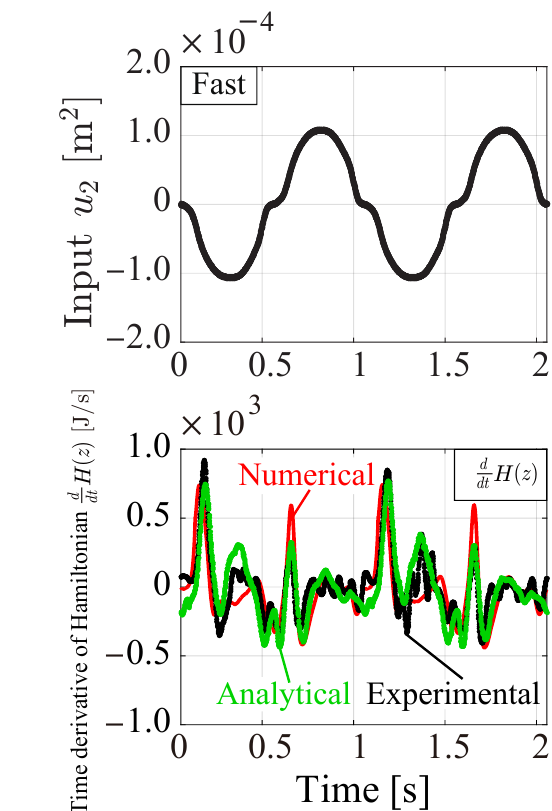
Figure 10. Experimental (black) vs. numerical (red) vs. analytical (green) time responses of the time derivative of the Hamiltonian. (Energy behavior analysis, slow: f = 0.5 [Hz], fast: f = 1.0